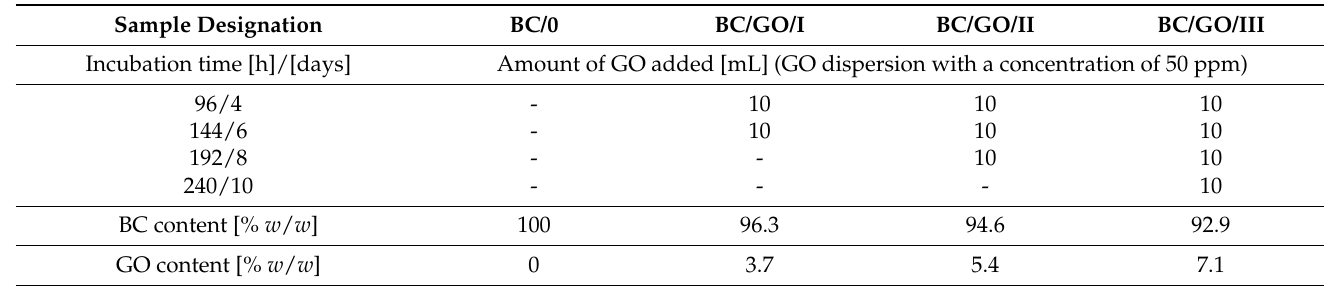
Table 1. Designation of samples and their